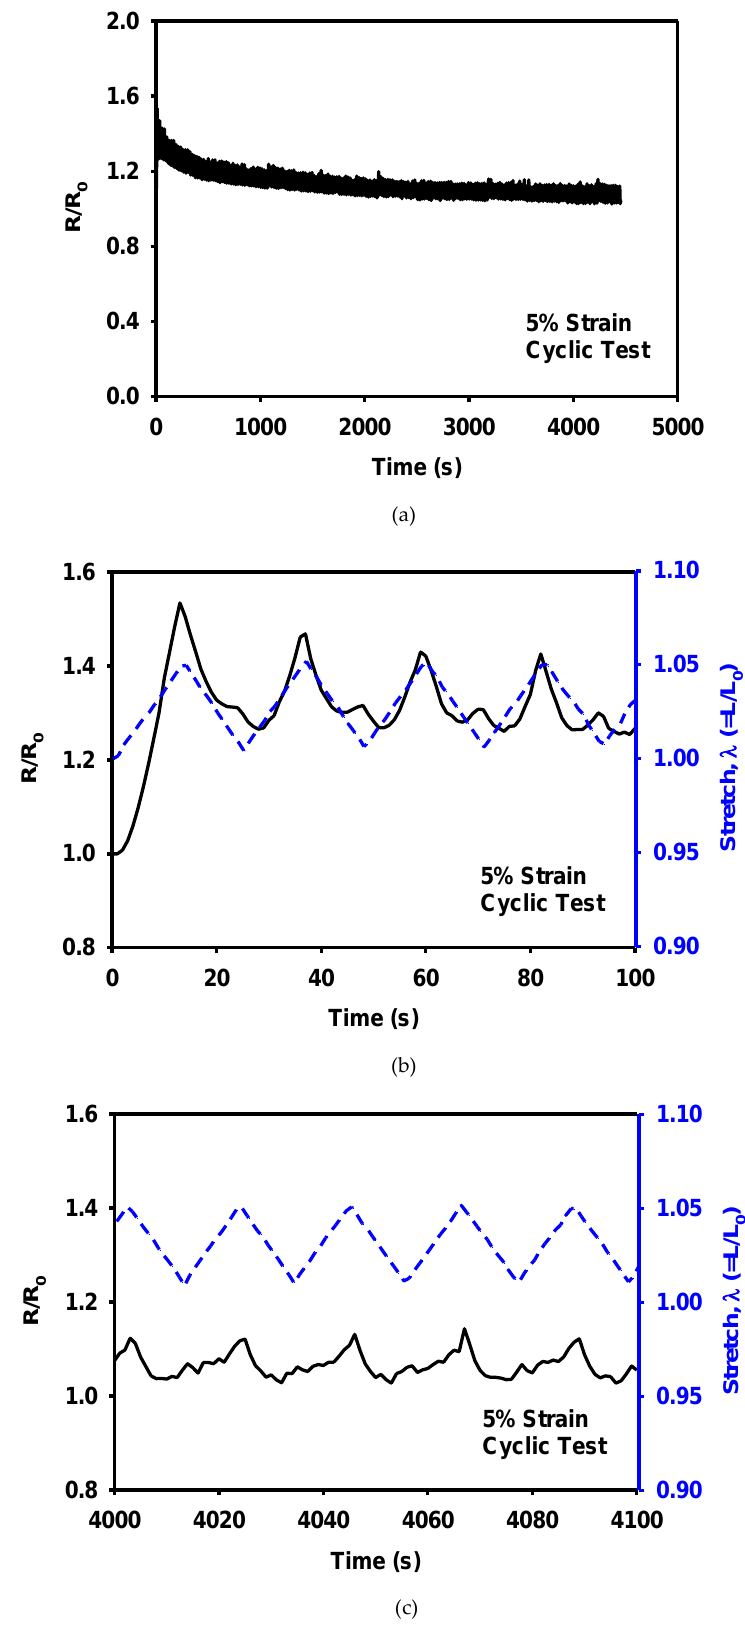
Figure 11. Evolution of piezoresistivity of the MWCNT/TPU composite during cyclic deformation: ( a ) the entire 200 cycles, ( b ) the initial cycles, and ( c ) the cycles after 180 cycles. The variation in the resistivity during uniaxial tension was calculated by the 3D resistance network model. Material parameters are listed in Table 2. In this work, the aspect ratio or the ratio of length to diameter of CNTs was limited to 80 in the 3D resistance network model due to the difficulties in computation. Table 2. Material parameters for 3D resistance network model. Parameter